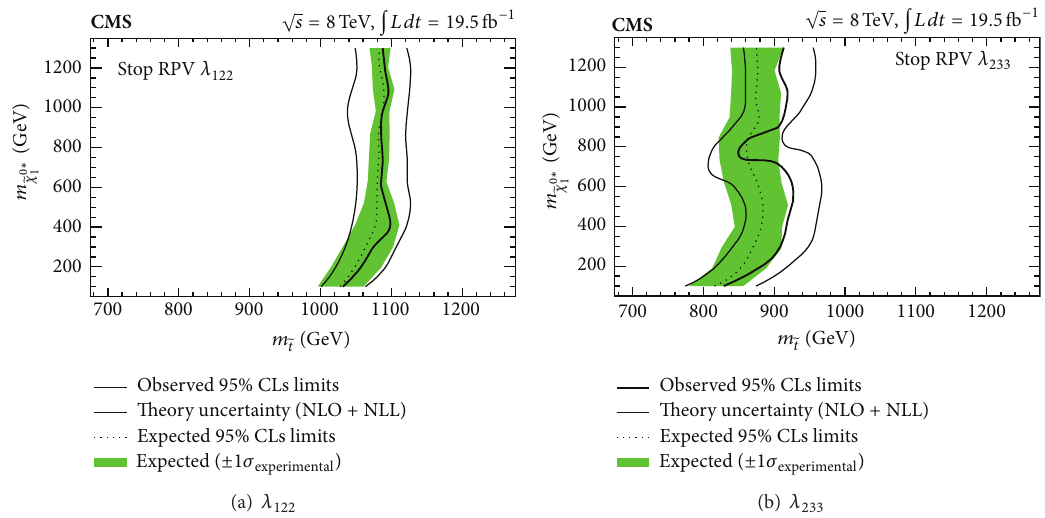
Figure 5: The 95% confidence level limits in the stop and bino mass plane for models with RPV couplings 𝜆 122 and 𝜆 233 . The region to the left of the curve is excluded (from [41]).